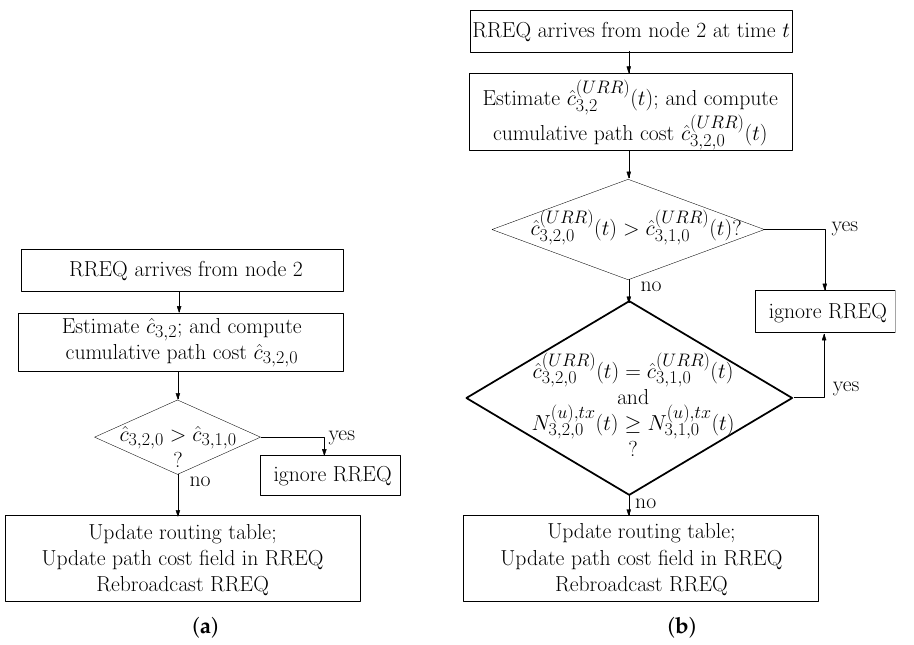
Figure 3. ( a ) ZigBee’s treatment of a route request (RREQ) message in the M2O routing